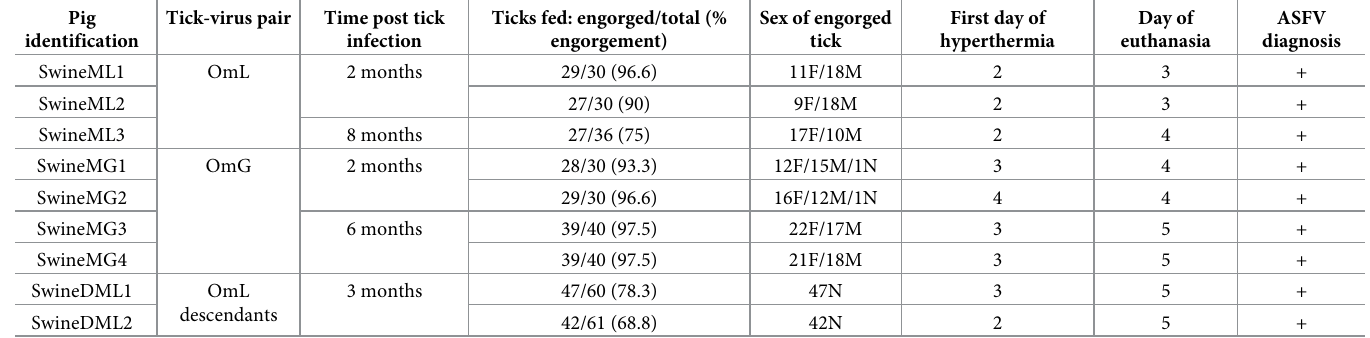
Table 2. ASFV transmission by O . moubata ticks. Experiments involved ticks previously exposed to ASFV strains OmL, OmG, and the descendants of OmL ticks. F = female, M = male, N = nymph, OmL = O . moubata -Liv13/33, OmG = O . moubata -Georgia2007/1. Pig identification